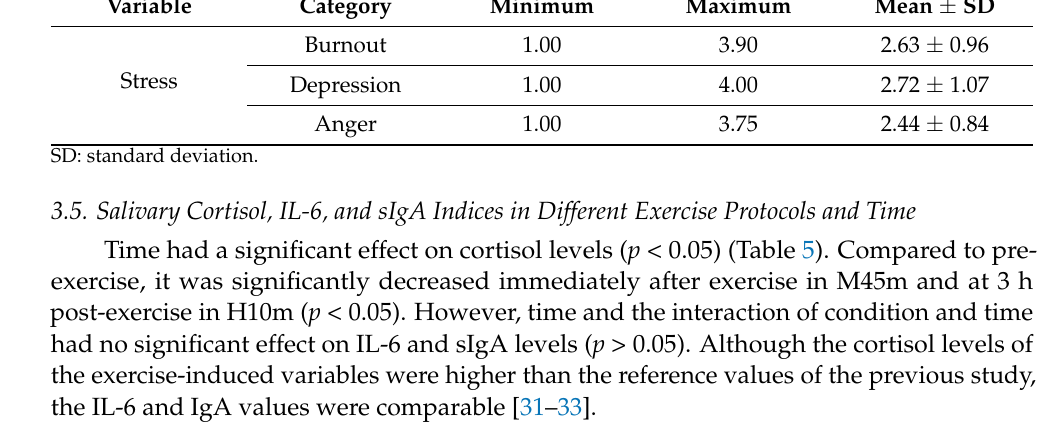
Table 5. Immune indexes of participants before and after different intensity exercise. Variable Time Pre Post Post 3 h Cortisol ( µ g/dL)